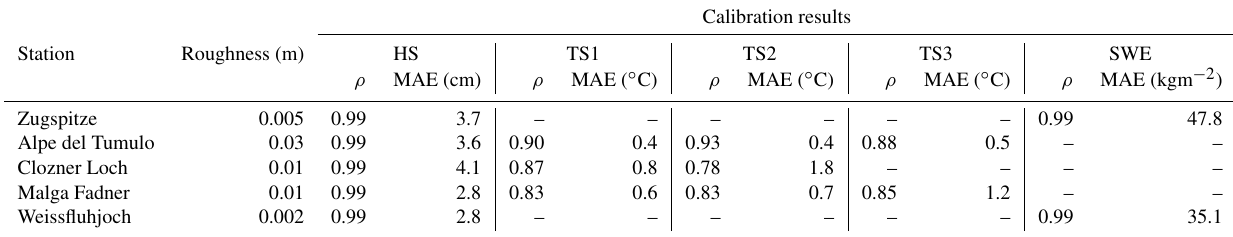
Table 3. SNOWPACK calibration results for each test site. The Pearson correlation coefficient ( ρ ) and the mean absolute error (MAE) have been computed for snow depth (HS); snow temperatures at three different depths – TS1 (0m from the ground), TS2 (0.2m from the ground), and TS3 (0.5m from the ground); and SWE, according to the availability of the in situ data.